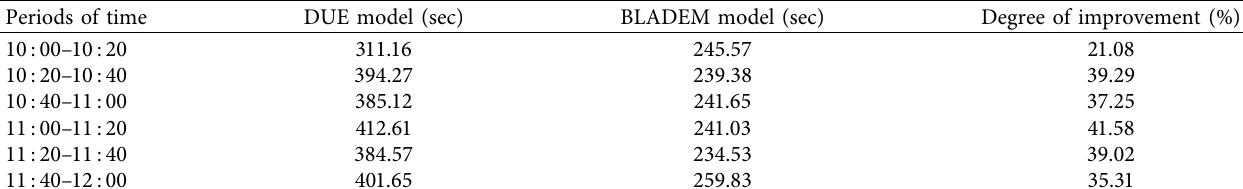
Table 2: Comparison of the running time.